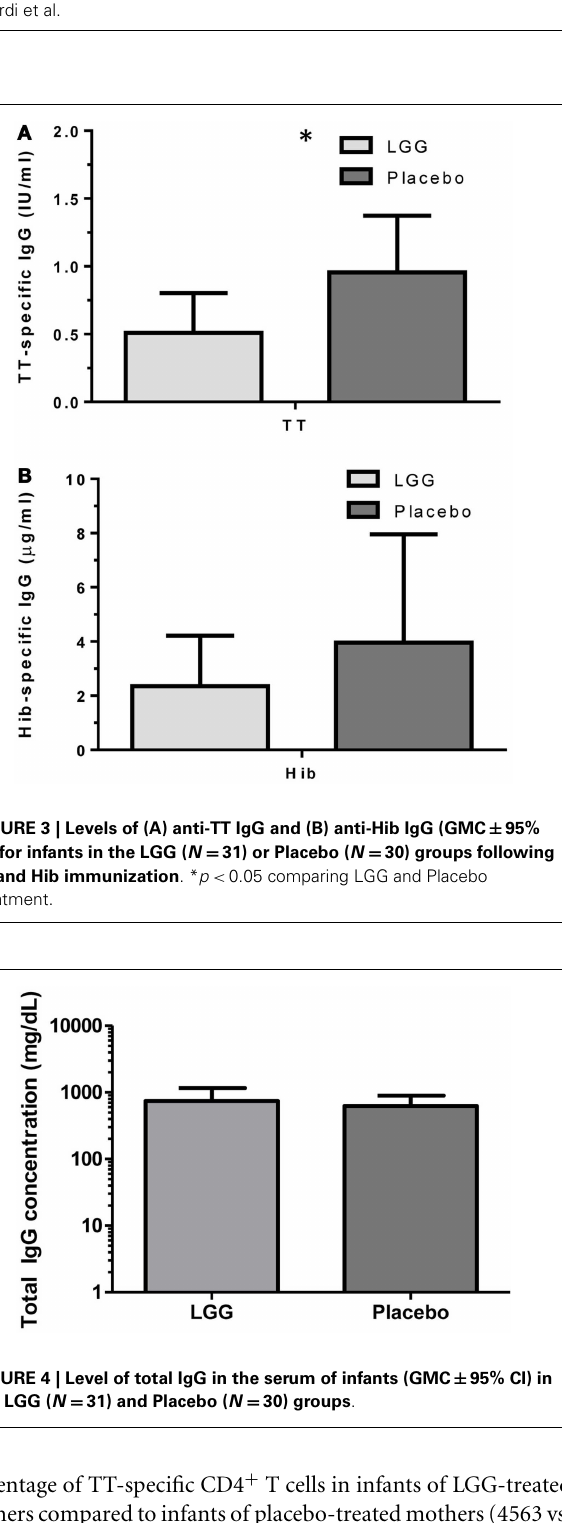
percentage of TT-specific CD4 + T cells in infants of LGG-treated mothers compared to infants of placebo-treated mothers (4563 vs. 3505; p = 0.027; 50.7 vs. 35.6%; p = 0.016) after stimulation